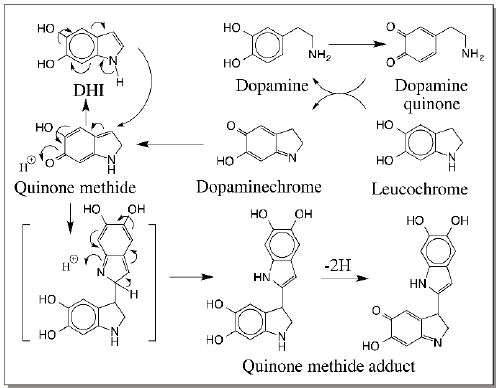
Figure 19. Formation of quinone methide adducts of dopamine during its oxidation. Dopamine quinone formed by the oxidation of dopamine undergoes intramolecular cyclization producing the leucochrome and then dopaminechrome. Isomerization of dopaminechrome to its quinone methide and aromatization of the catecholic ring produces DHI. A quinone methide adduct of DHI in its oxidative stage has been characterized from the reaction mixture. Oxidations of norepinephrine as well as epinephrine exhibit the quinone → leucochrome → iminochrome → indole transformations (Figure 20). The presence of hydroxyl group at 3-position will allow the quinone methide intermediate to rearrange and form the adrenolutin/noradrenolutin [71,72]. Norepinephrine quinone has been shown to isomerize to quinone methide and produce 2-hydroxy-3 ′ ,4 ′ -dihydroxyacetophenone and a number of side chain oxidized products [72].